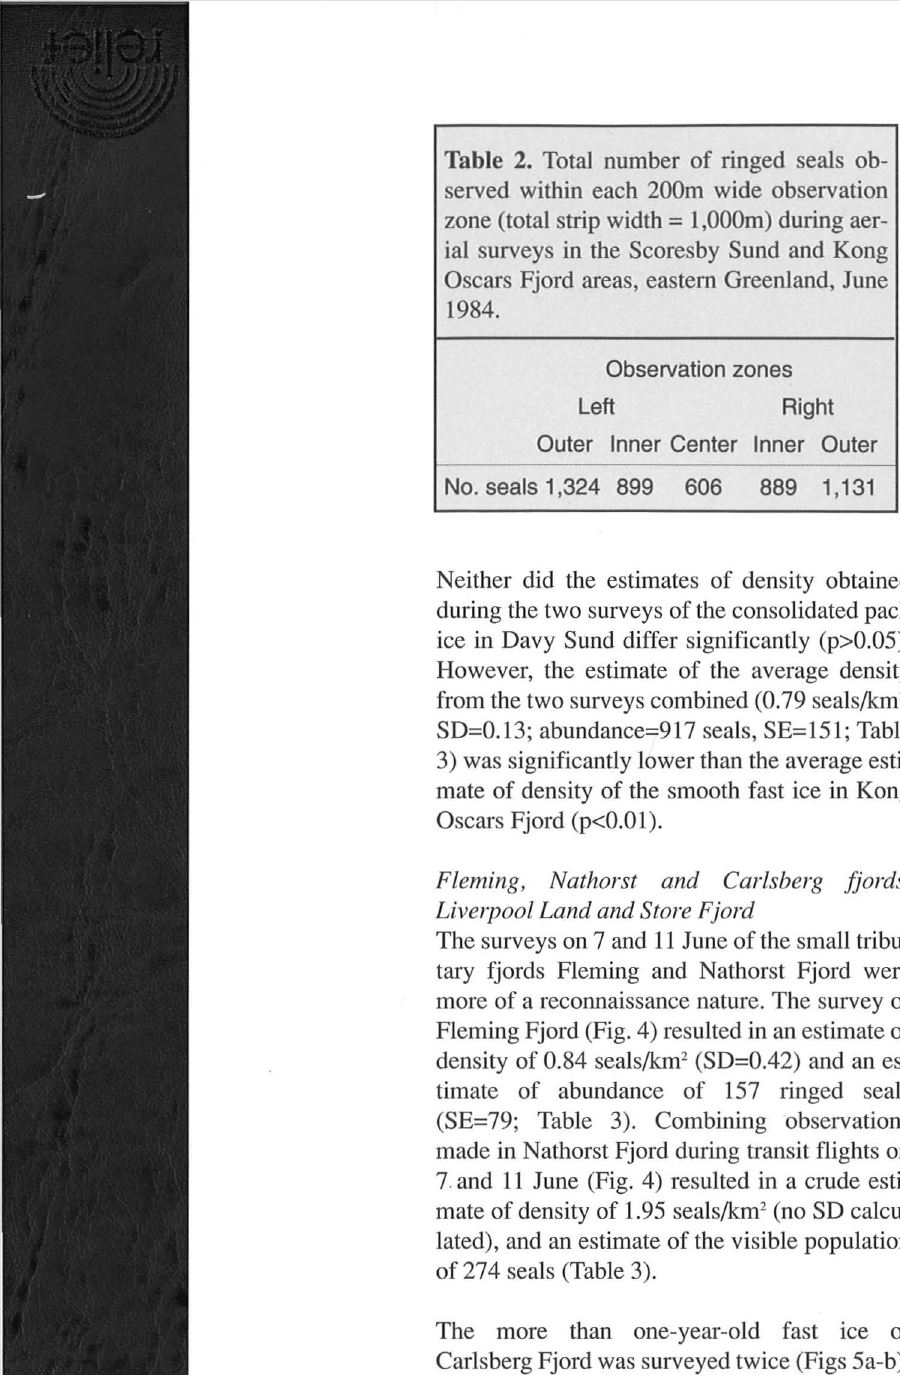
Table 2. Total number of ringed seals ob- served within each 200m wide observation zone (total strip width = 1,000m) during aer- ial surveys in the Scoresby Sund and Kong Oscars Fjord areas, eastern Greenland,